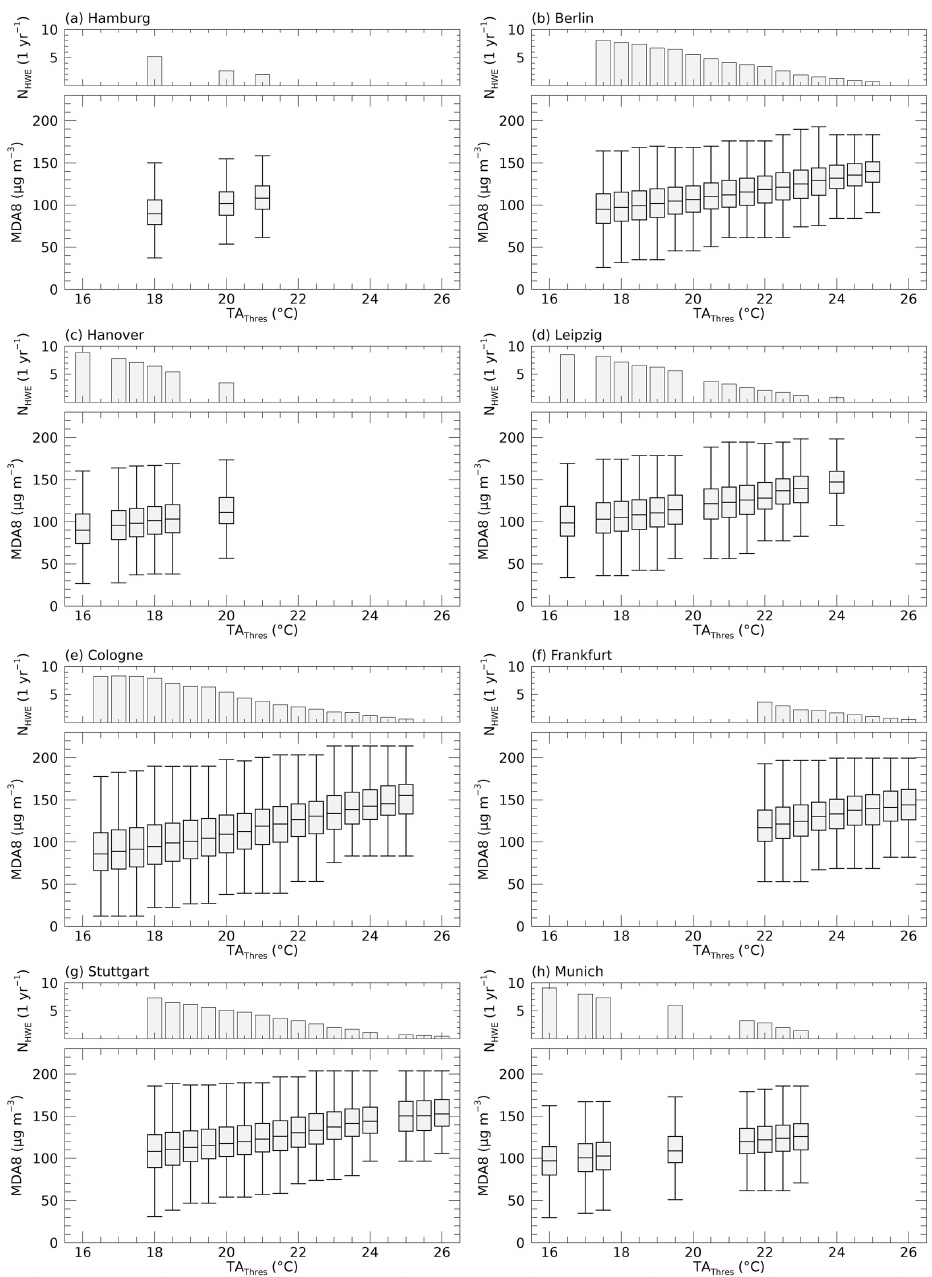
Figure 4. Top row of each panel: average number of HWEs per year ( y axis), detected per TA Thres ( x axis). Box-and-whisker plots display daily values of MDA8 during detected HWEs. Boxes refer to the range between the 25th and 75th percentile (inter quartile range IQR), median values are given as solid lines, and whiskers are the minimum and maximum values excluding outliers (less than Q 1 − 1 . 5 · IQR, greater than Q 3 + 1 . 5 · IQR). Only results of overall statistically significant ( F test, p < 0.05) MLR models are